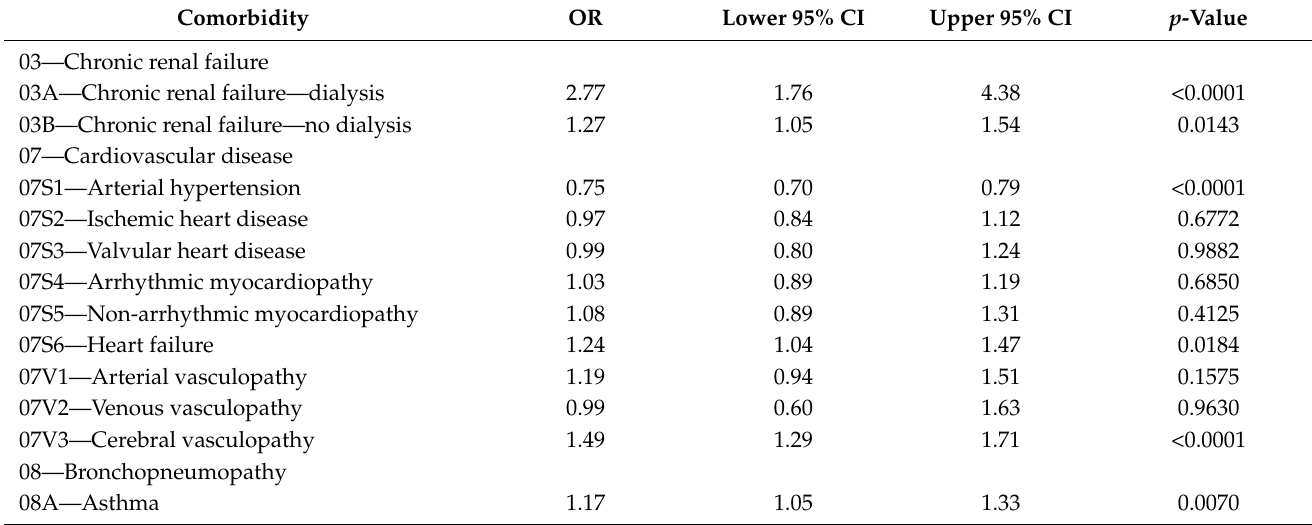
Table 4. Detail of the main comorbidities implicated in reinfected SARS-CoV-2 patients from Septem- ber 2021 to May